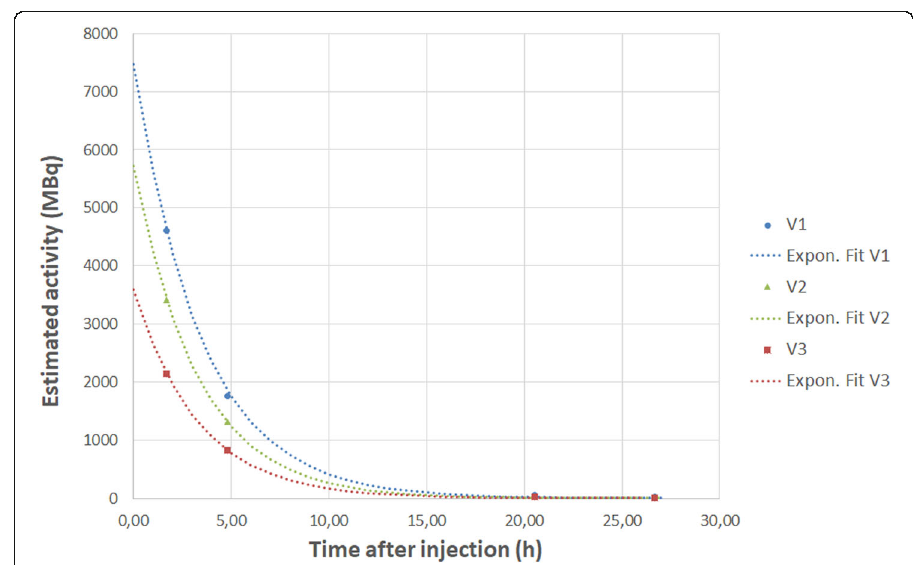
Fig. 9 Estimated time activity curves for the 3 VOI of 1000, 400, and 180 mL